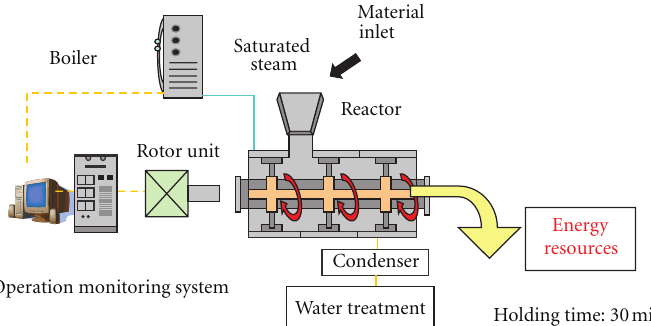
Figure 1: Hydrothermal treatment system.